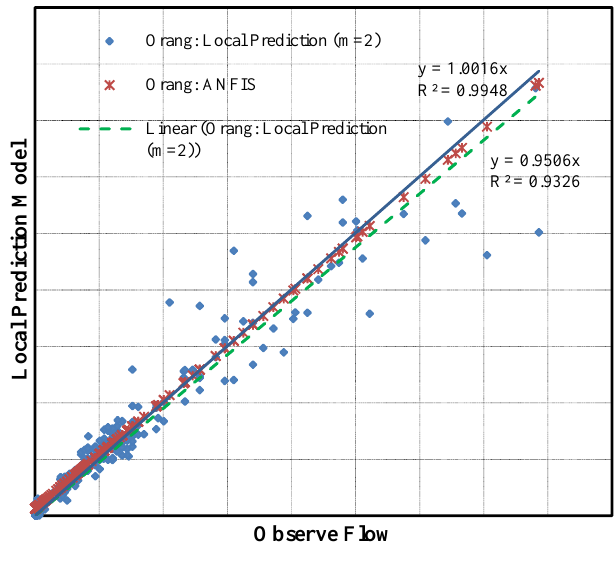
Fig.10 Scatter Diagram for the Models at Orang